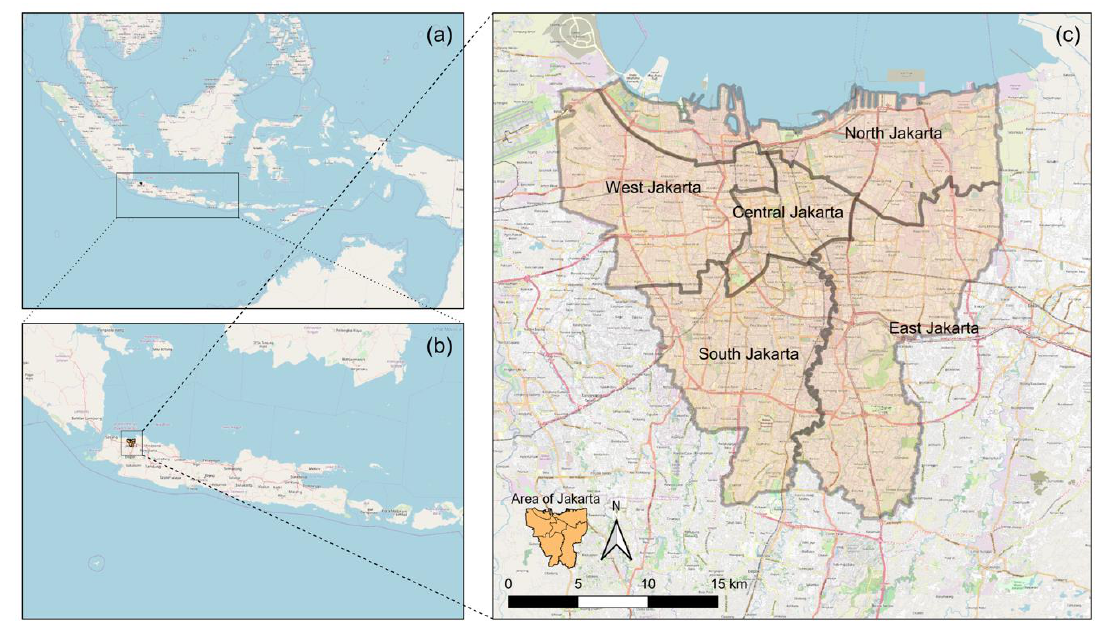
Figure 2. ( a ) Map of Indonesia; ( b ) Jakarta is located on Java island, which is the densest island in Indonesia; ( c ) Jakarta consists of five municipalities.